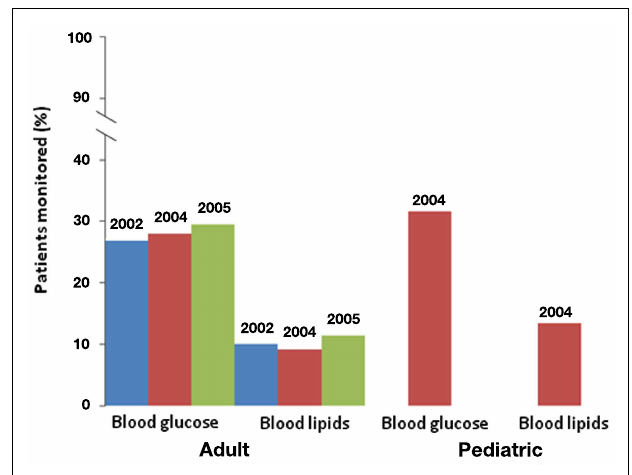
FIGURE 1 | Blood glucose and lipid monitoring in adult and pediatric patients. In adult patients, monitoring did not significantly change after the Dec. 2003 FDA warning. Monitoring is also low in pediatric patients after the warning. Data from Morrato et al. (2010a,b).